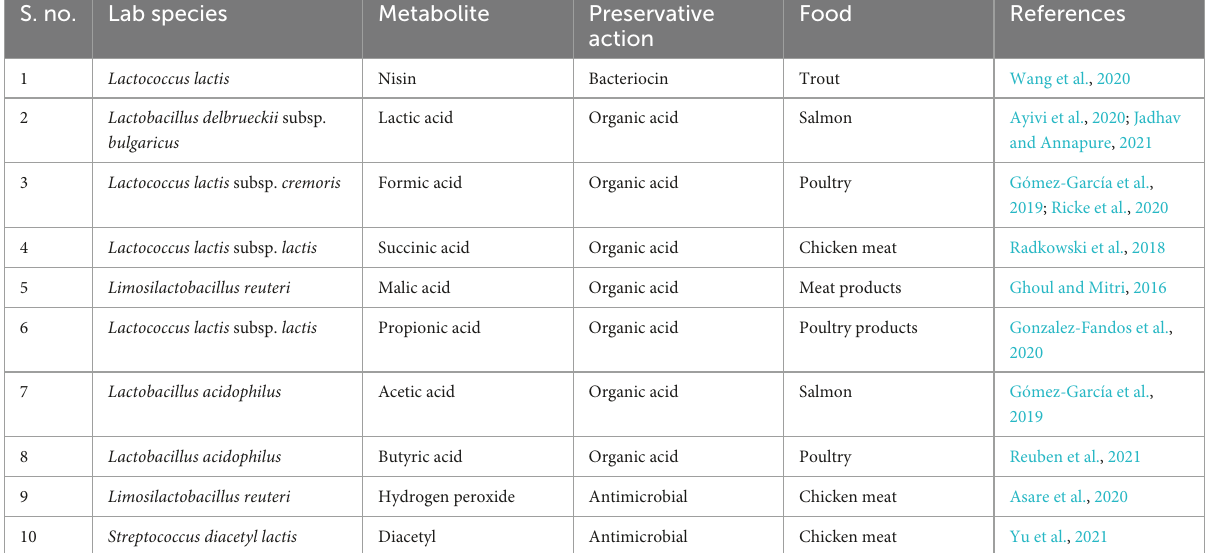
TABLE 1 Application of LAB-produced bacteriocins and organic acids in chicken and seafood. S.